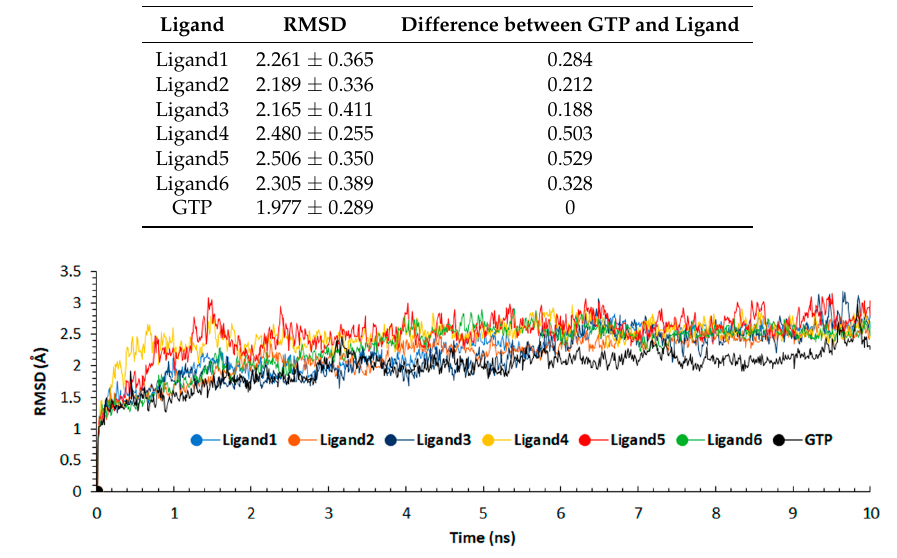
Figure 8. RMSD calculation for 10 ns of production for each ligand and